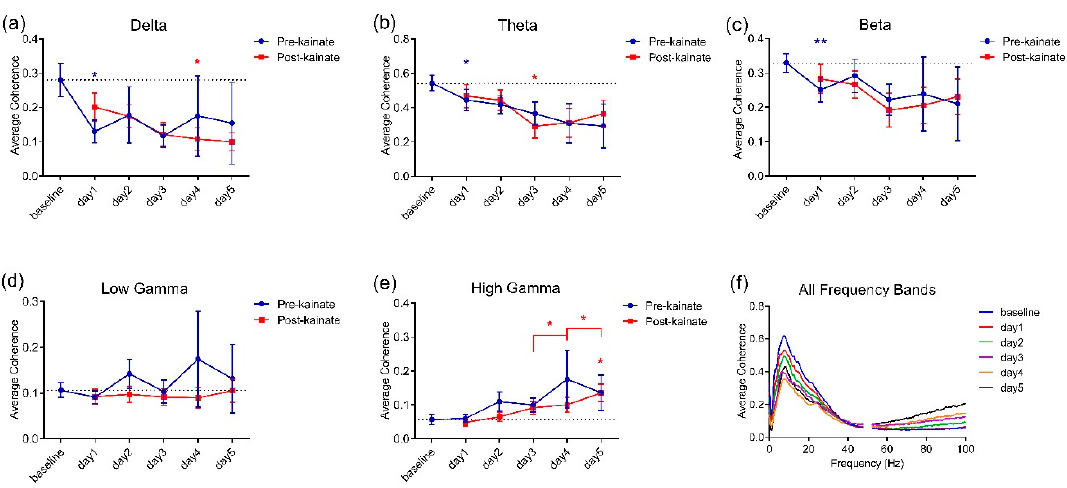
Figure 2. Average interhemispheric coherence between primary motor cortices before (baseline day) and after 5 days of repeated vermis cerebellar kainate administration across different frequency spectral bands. ( a ) Delta band (0.5–3.5 Hz). ( b ) Theta band (4–12.5 Hz). ( c ) Beta band (13–30 Hz). ( d ) Low-gamma band (30.5–48 Hz). ( e ) High-gamma band (52–100 Hz) frequencies in baseline day and kainate administration day. ( f ) For each frequency band, the coherences are expressed as average ± the standard error of the mean (* for p < 0.05 and ** for p < 0.01, day of kainate application versus baseline day; statistical tests detailed in Table 1). Table 1. Interhemispheric coherence between primary motor cortices. Statistical data (Figure